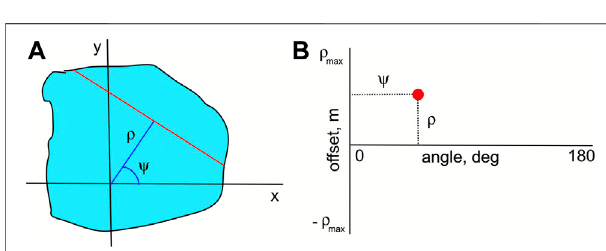
FIGURE 3 | Radon transform geometry: (A) in the physical space the extinction coef fi cient (light blue) is integrated along the chord (red) parameterized by the angle ψ and the offset ρ in order to get the directional COT τ d ( ψ , ρ ); (B) the representation (red dot) of the location where this chord ’ s value τ d ( ψ , ρ ) is placed in the Radon ’ s tomogram.